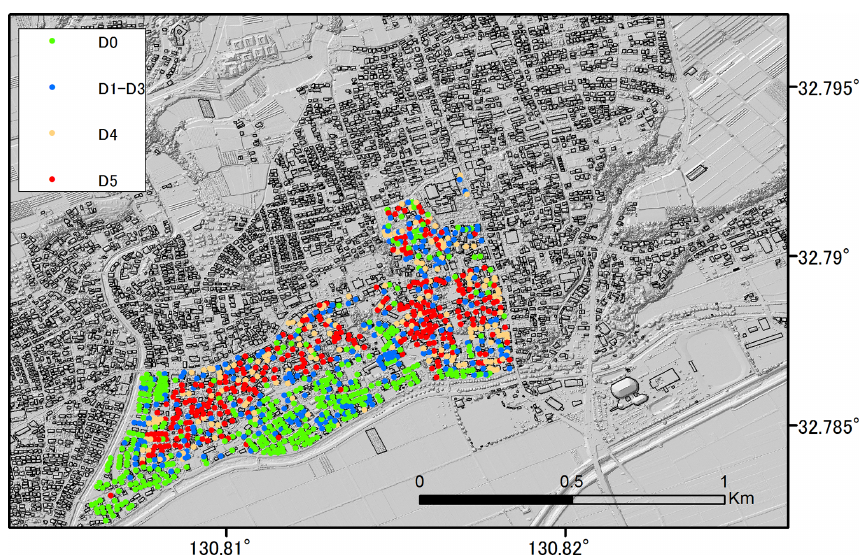
Figure 5. Building damage survey data from Yamada et al. (2017). The location of the survey area is shown in Fig.